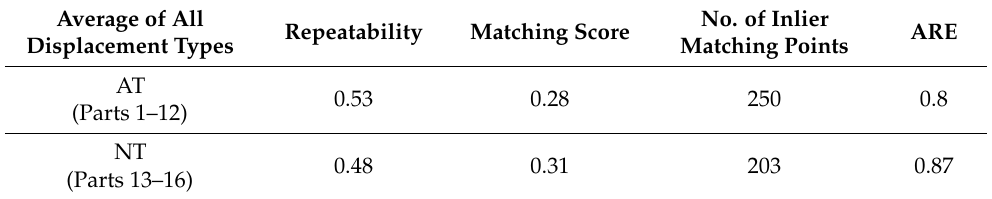
Table 3. Average values for feature performance evaluation of KAZE method with ATs and